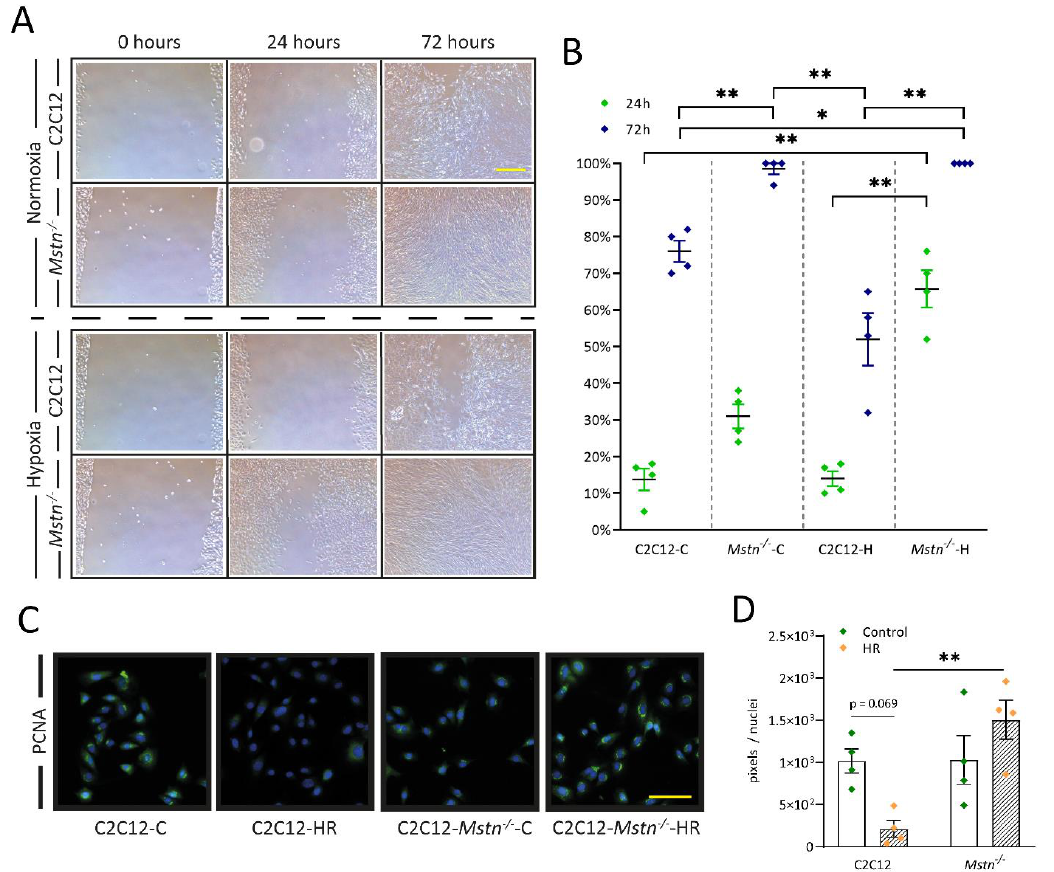
Figure 6. Elevated proliferation of C2C12- Mstn −/− cells under hypoxic conditions and measurement of DNA replication. ( A ) Images of the scratch array measuring the temporal progression of cell migration and proliferation under normoxic and hypoxic conditions. ( B ) Graph depicting percentual coverage (x-axis) of the initial defined gap after 24 h (green symbols) and 72 h (blue symbols) for C2C12 and C2C12- Mstn −/− cells under normoxic ( C ) and hypoxic (H) conditions. ( C ) Representative images at 40× magnification and ( D ) immunofluorescence analysis of proliferative activity (PCNA). Cell nuclei were counterstained with DAPI. C, control cells incubated under normoxia. H, cells incubated under hypoxic conditions for 72 h. HR, cells incubated under hypoxic conditions for 4 h followed by normoxia for 15 min. For each graph, four independent experiments per group were conducted. Scale bar = 50 µ m. Results are shown as means ± SEM. p -value: * < 0.05, ** < 0.01; ANOVA followed by a multiple test comparison via Tukey’s post-hoc test (homoscedasticity) or Brown–Forsythe and Welch ANOVA followed by Dunnett’s T3 post-hoc test